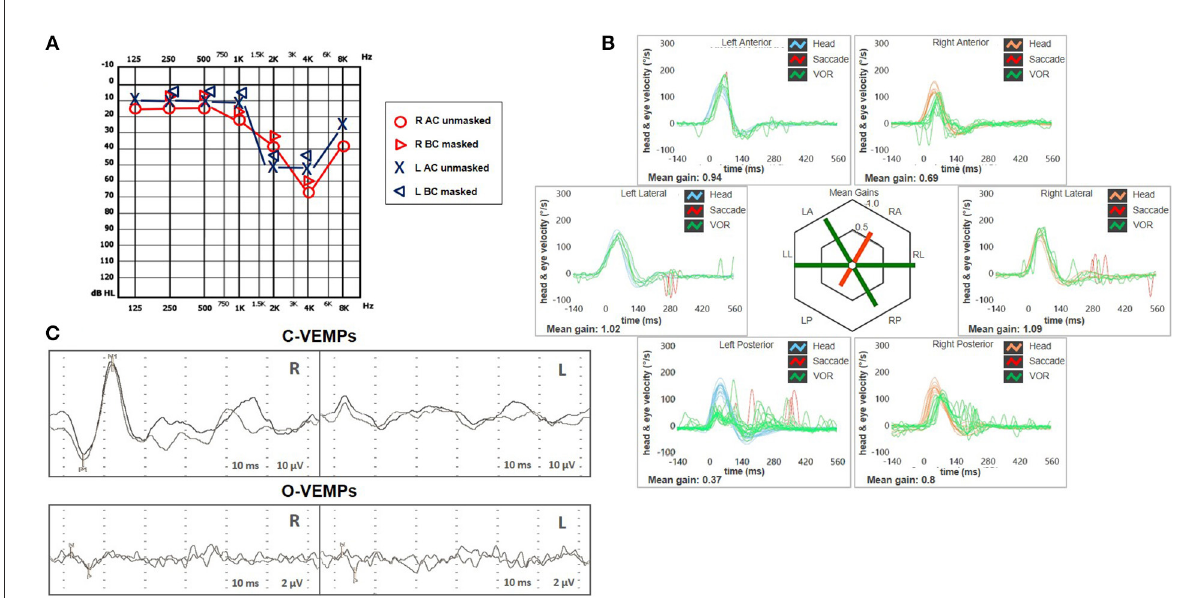
FIGURE2 Presenting scenario including (A) Pure-tone audiometry exhibiting bilateral high-frequency sensorineural hearing impairment, slightly greater on the right side. (B) Video-HIT was performed using a portable high-frame-rate video-oculography device (ICS Impulse, Natus Medical Inc, Denmark). Blue lines represent head impulses exciting left canals, orange lines correspond to impulses for right canals, green lines represent eye movements induced by the activation of VOR following each impulse, and red lines correspond to corrective saccades. The mean value of VOR-gain (eye velocity/head velocity) is reported for each canal. The hexagonal plot in the center of the figure summarizes the mean VOR gains for each canal; normal gains are shown in green, and deficient gains are in red. Gains are considered normal if > 0.8 for lateral canals and > 0.7 for vertical canals. A severe VOR-gain impairment for the left PSC (0.37) with mainly overt saccades can be observed, and a slight reduction of contralateral ASC VOR-gain (0.69). (C) C-VEMPs (above) and O-VEMPs (below) for air-conducted sounds recorded with a 2-channel evoked potential acquisition system (Viking, Nicolet EDX, CareFusion, Germany). Potentials were measured by delivering tone bursts (intensity: 100 dB nHL, frequency: 500Hz, duration: 8ms, stimulation rate 5Hz) via headphones. The recording system used an EMG-based biofeedback monitoring method to minimize variations in muscle contractions and VEMPs amplitudes. Each stimulus was retested to assess the reproducibility of responses. For C-VEMPs, right and left lines correspond to myogenic responses (p1–n1) recorded on the right and left SCM muscle (i.e., right and left saccular responses), respectively. For O-VEMPs, being crossed responses, right and left lines representing potentials (n–p) are recorded under the left and right eye (i.e., right and left utricular responses), respectively. VEMP testing revealed normal responses on the right side (105.5 µ V) and absent potentials on the left, whereas symmetrical amplitudes for ocular VEMPs (R: 4.4 µ V and L: 5.7 µ V) could be detected. AC, air-conduction; ASC, anterior semicircular canal; BC, bone-conduction; C, cervical; HIT, head impulse test; L, left; LA, left anterior; LL, left lateral; LP, left posterior; O, ocular; PSC, posterior semicircular canal; R, right; RA, right anterior; RL, right lateral; RP, right posterior; SCM, sternocleidomastoid; VEMPs, vestibular evoked myogenic potentials; VOR, vestibulo-ocular